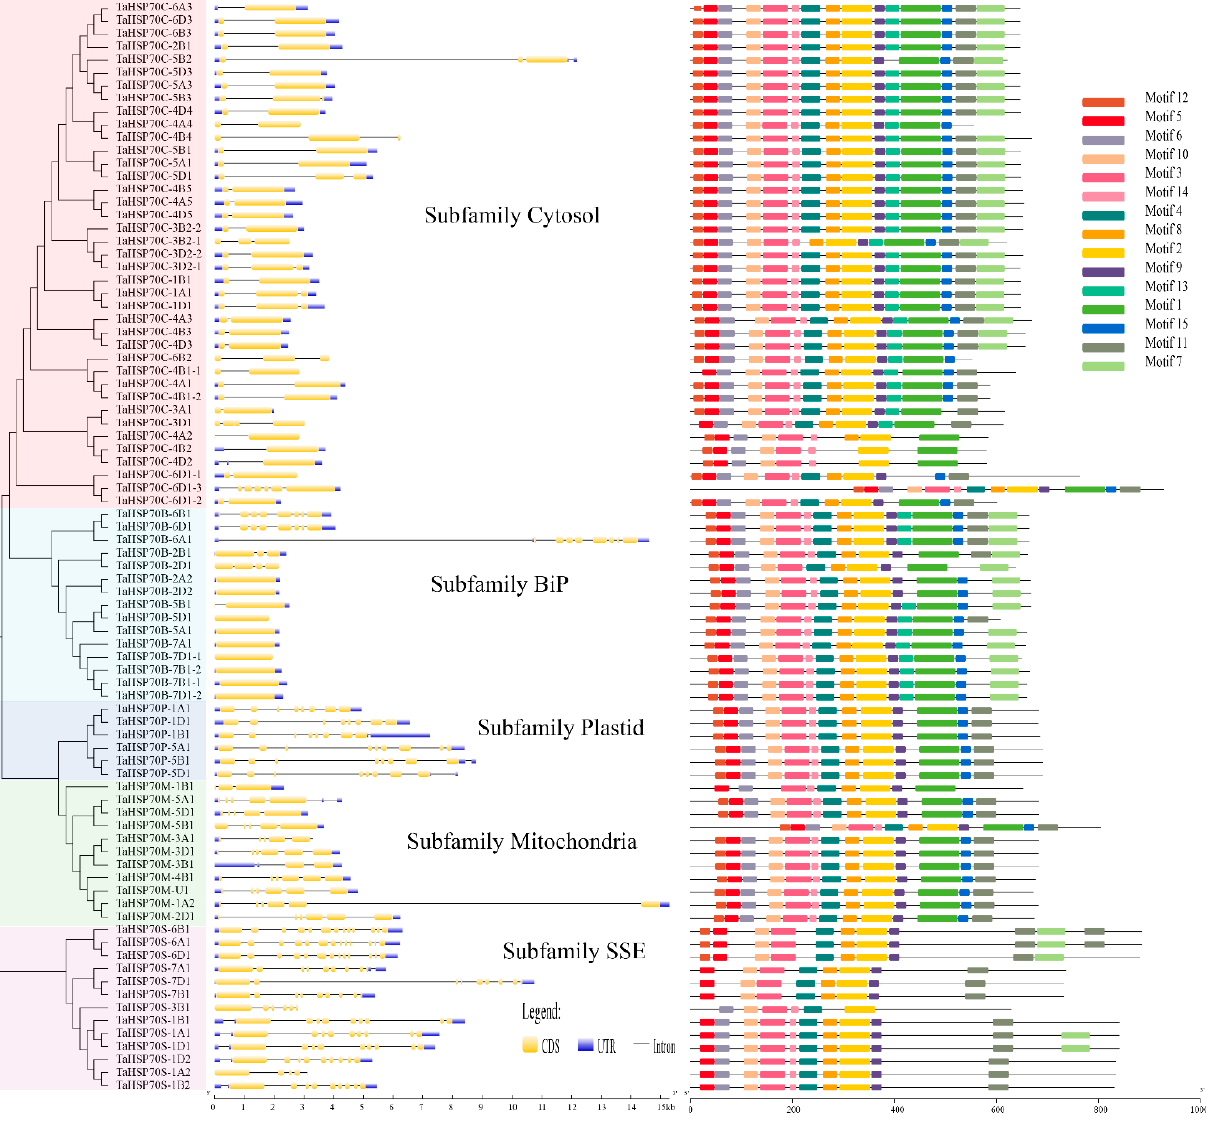
Figure 5. Exon/intron structures, protein motifs of TaHSP70s .